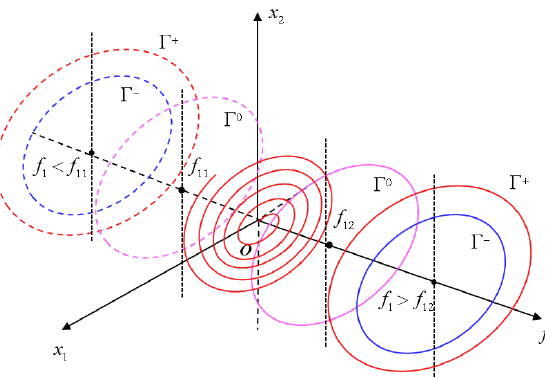
Figure 11. Bifurcation of periodic orbits in ( x 1 , x 2 , f 1 )